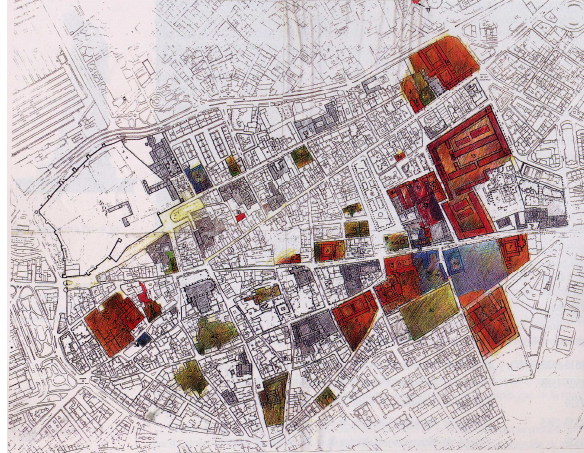
Figure 8. Drawings of different actions on the World Heritage Alcala.